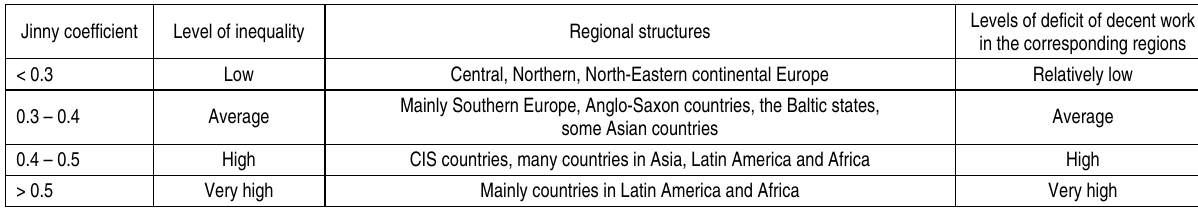
Table 2. Data, which characterize regional disparities (inequalities) in the income of the